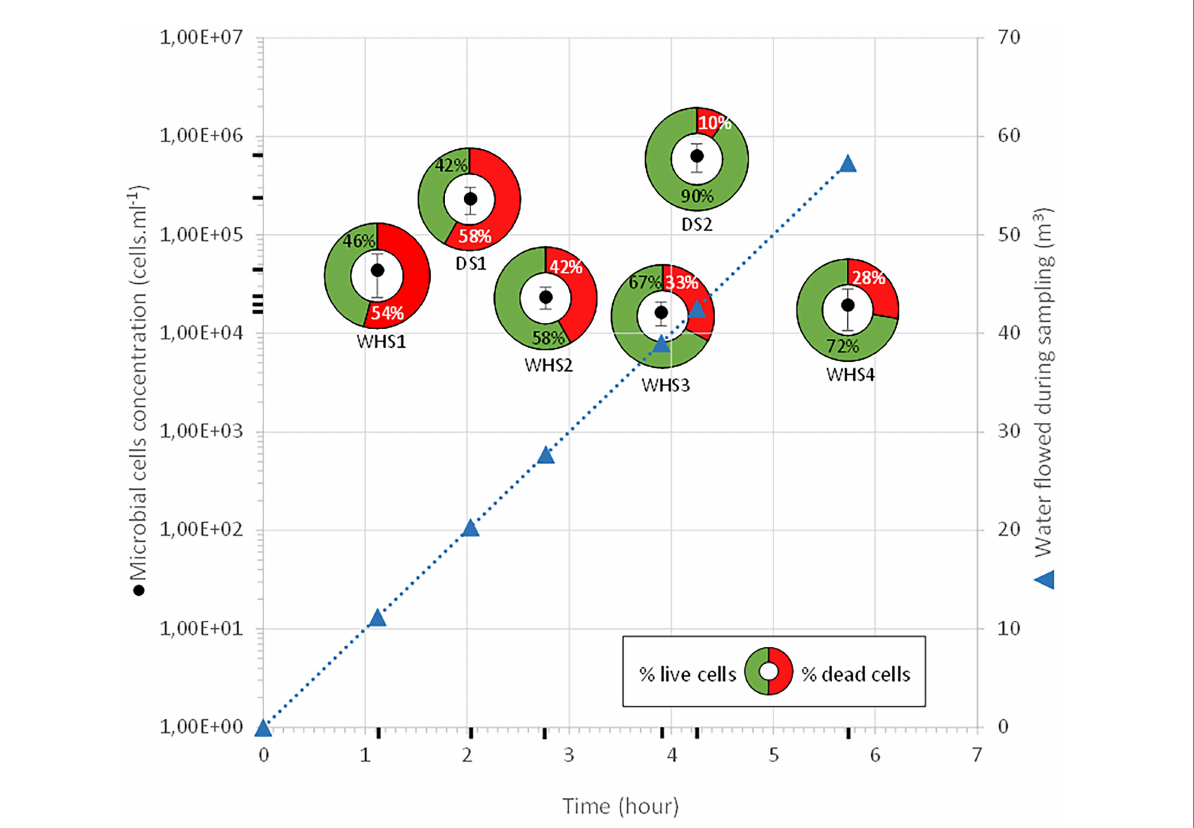
FIGURE 2 Enumeration and cell survival during the sampling campaign. The black circles represent total cell counts. For each of these counts, the cells with intact membranes, qualified as living cells, are represented in green, while the cells with lysed membranes, qualified as dead cells, are shown in red. As the well is artesian throughout the procedure, the volume of water purged is represented with blue triangles. DS: downhole sampling; WHS: wellhead